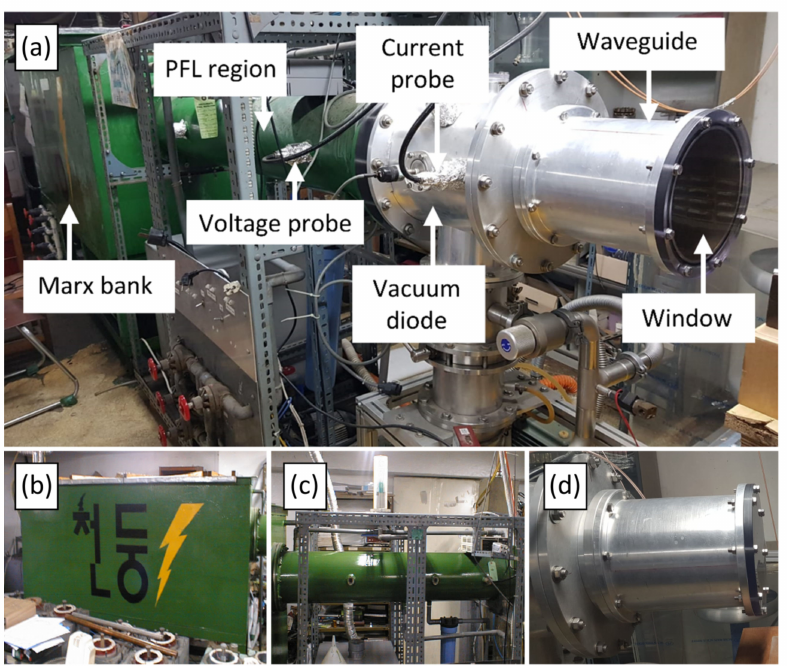
Figure 2. ( a ) Photographs of the “Chundoong” pulsed high-power microwave generator. This device is divided into three major components, which are depicted separately as ( b ) the Marx bank for generating high voltage pulses, ( c ) the pulse forming line, and ( d ) the vacuum diode